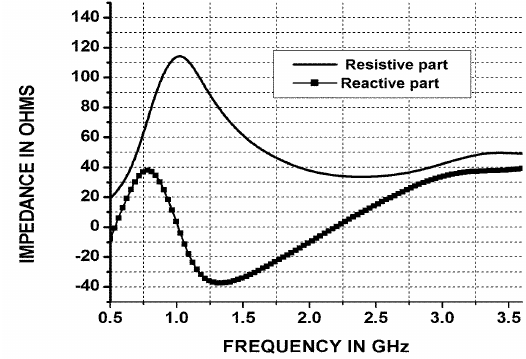
Figure 4: Impedance Characteristics of CSA